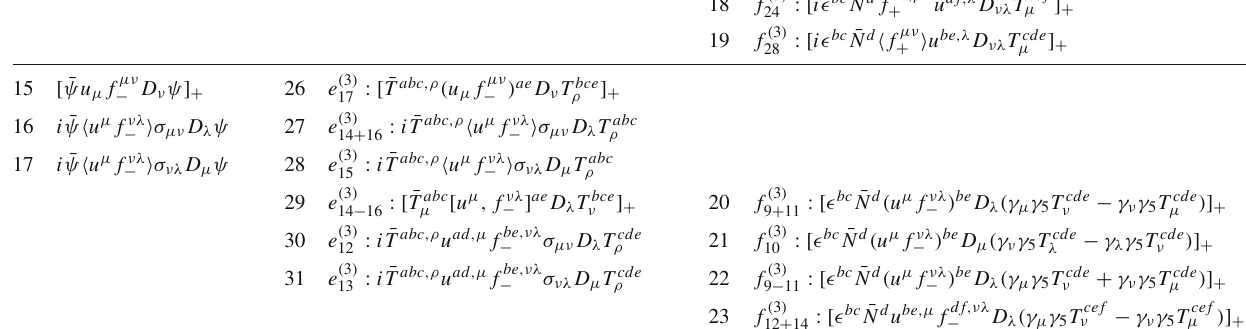
Table 3 The O ( p 3 ) chiral-invariant Lagrangians L π NN , L π qq , L π(cid:2)(cid:2) , and L π N (cid:2) . ψ in L π NN /π qq means N /ψ q of Eq. (1) and (cid:9)···(cid:10) means trace in flavor space. The symbol [···] + stands for [···] + h . c . . We